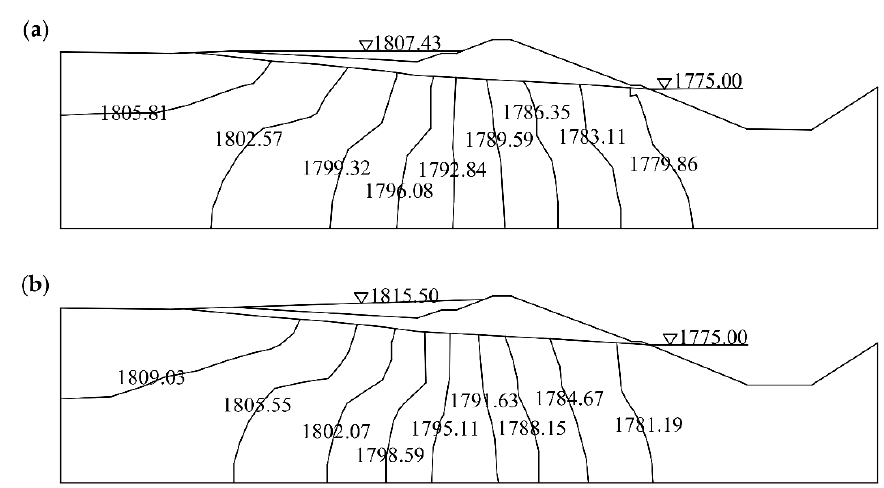
Figure 5. Potential distributions of the seepage field at a typical cross-section of the dam body: ( a ) in